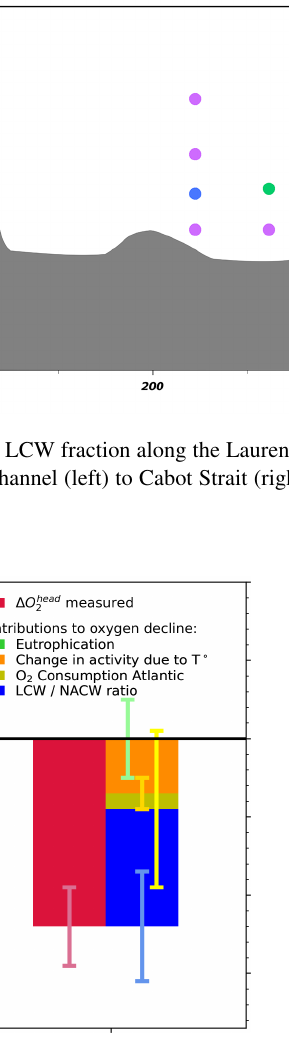
Figure 8. Budget of drivers of deoxygenation at the head of the LSLE, from 2018 to 2021. Green: eutrophication within the Lauren- tian Channel; orange: increased dissolved oxygen (DO) consump- tion within the channel under increased water temperature; yellow: change in DO consumption in the North Atlantic, from the site of LCW and NACW mixing on the continental shelf or slope to Cabot Strait; blue: modification of the LCW:NACW ratio at the entrance of the Laurentian Channel. See Jutras et al. (2020b) for details on the calculation